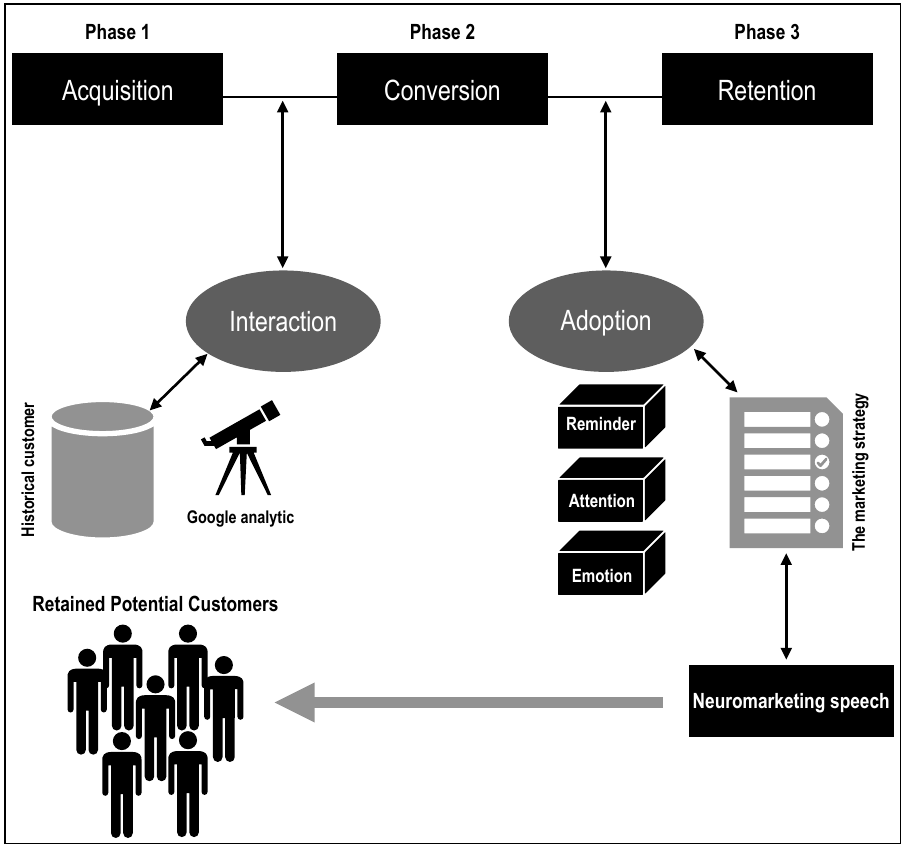
Figure 1. Insight RECONAC